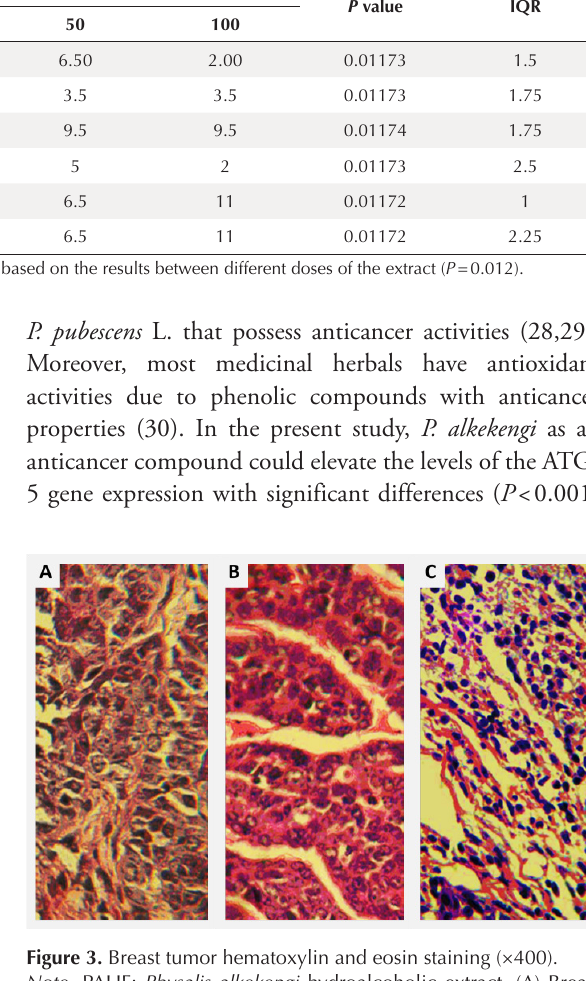
Table 2. Macroscopic and histological indices in the breast cancer tissue following treatment by hematoxylin and eosin staining by Kruskal-Wallis analysis Indices